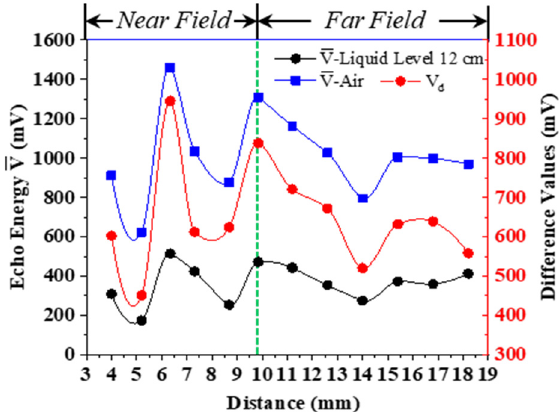
Figure 6. The impact of ultrasonic field on experimental results.